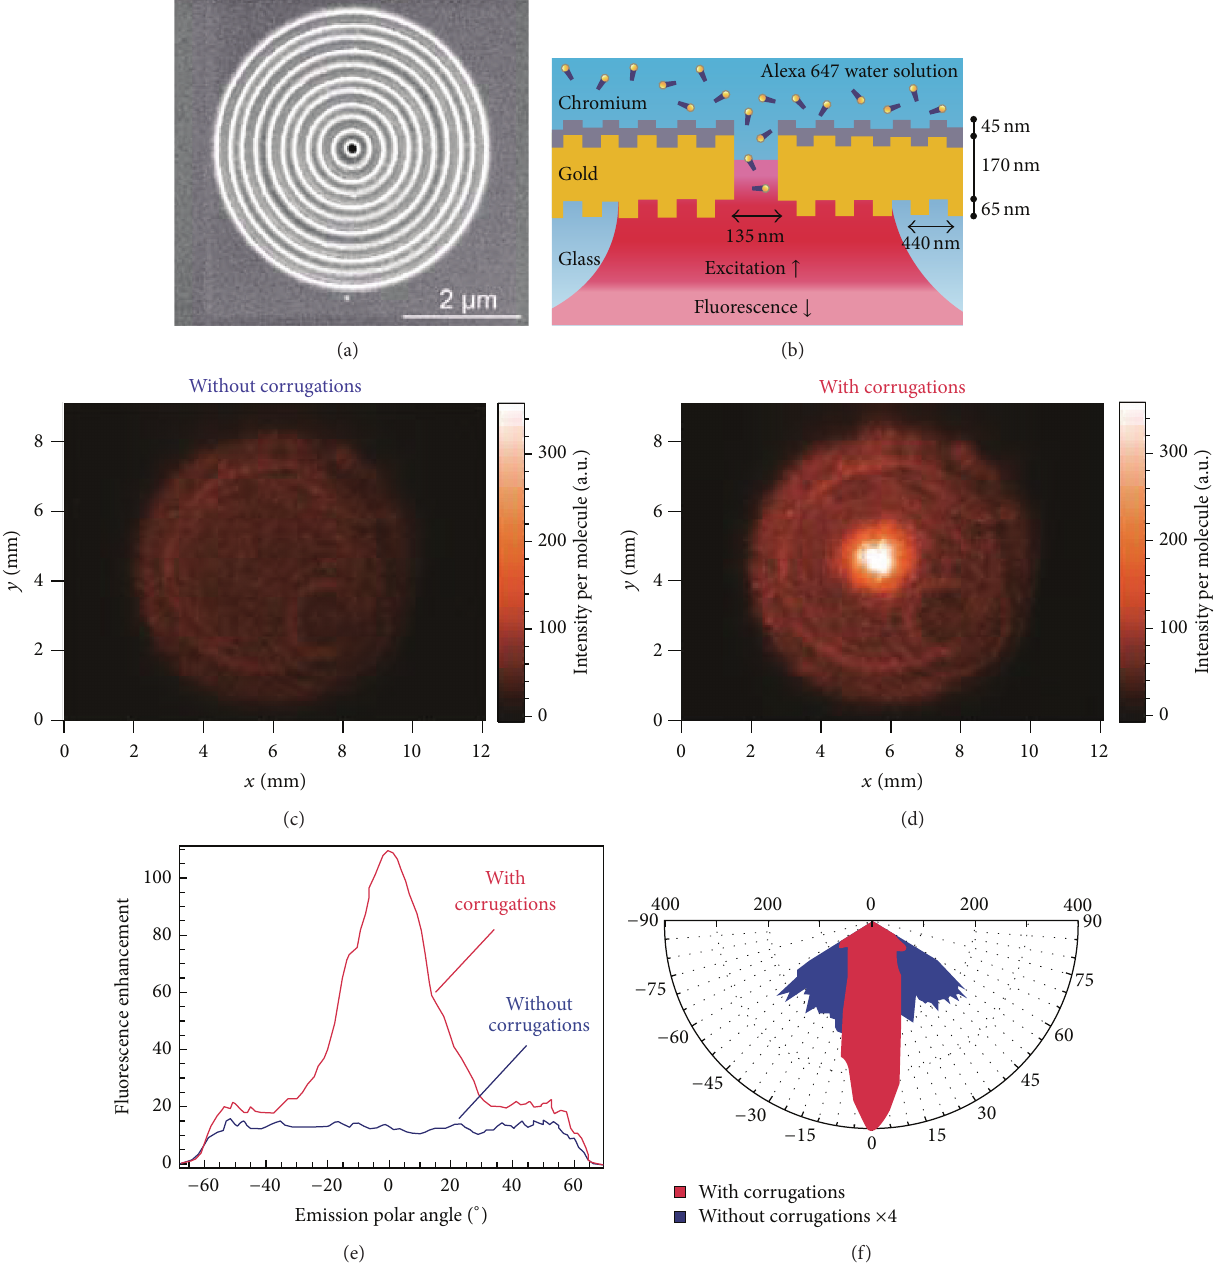
Figure 30: Directional radiation of fluorescent molecules. (a) SEM image of the fabricated nanoaperture with five corrugations. (b) Configuration to enhance and control the fluorescence emission of molecules diffusing in the central aperture. (c, d) Radiation patterns (intensity distribution in the back focal plane of the 1.2 NA objective) for a single nanoaperture without (a) and with (b) periodic corrugations. (e) Fluorescence intensity enhancement per single molecule as function of the emission polar angle, relative to the open solution reference case. (f) Angular radiation patterns in the polar angle. Figures are reproduced from